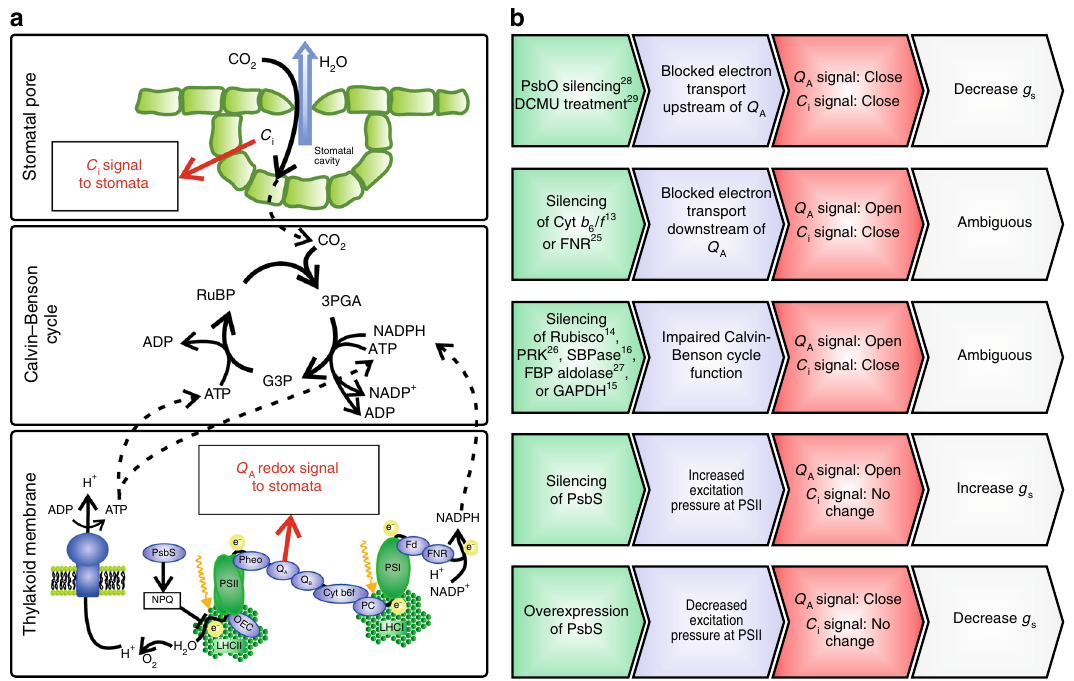
Fig. 4 Interactions between light and CO 2 control over stomatal movements. a Schematic representation of processes in the chloroplast thylakoid membrane, Calvin – Benson cycle in the chloroplast stroma, and at the interchange between intercellular airspace and atmosphere through the stomatal pore. Indicated are where the CO 2 signal ( C i signal) and the proposed Q A -redox signal originate. b Chain of events showing the direct effects on the stomatal control signals from C i and Q A redox state of the manipulation of PsbS expression in the current work and several previously published manipulations, and the subsequent direction of change in stomatal conductance ( g s ). Superscripted numbers indicate corresponding literature references. Abbreviations: 3PGA – 3-Phosphoglycerate; ADP – adenosine diphosphate; ATP – adenosine triphosphate; Cyt b 6 f – Cytochrome b 6 f ; DCMU –